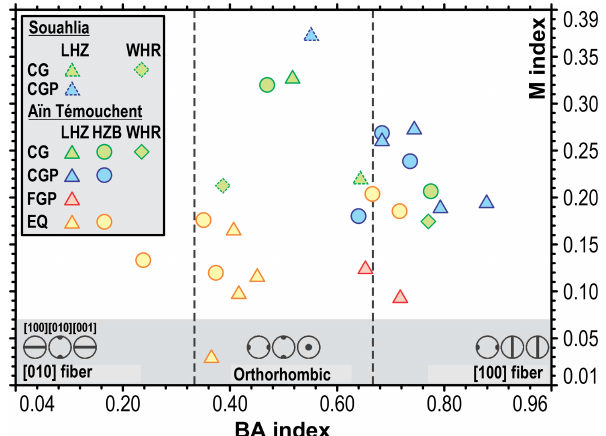
Figure 4. BA index of olivine in the function of olivine fabric strength (expressed as M index). Vertical dashed lines show the guidelines for differentiating [010]-fiber, orthorhombic and [100]- fiber CPO symmetries. Abbreviations in the legend are the same as for Fig.